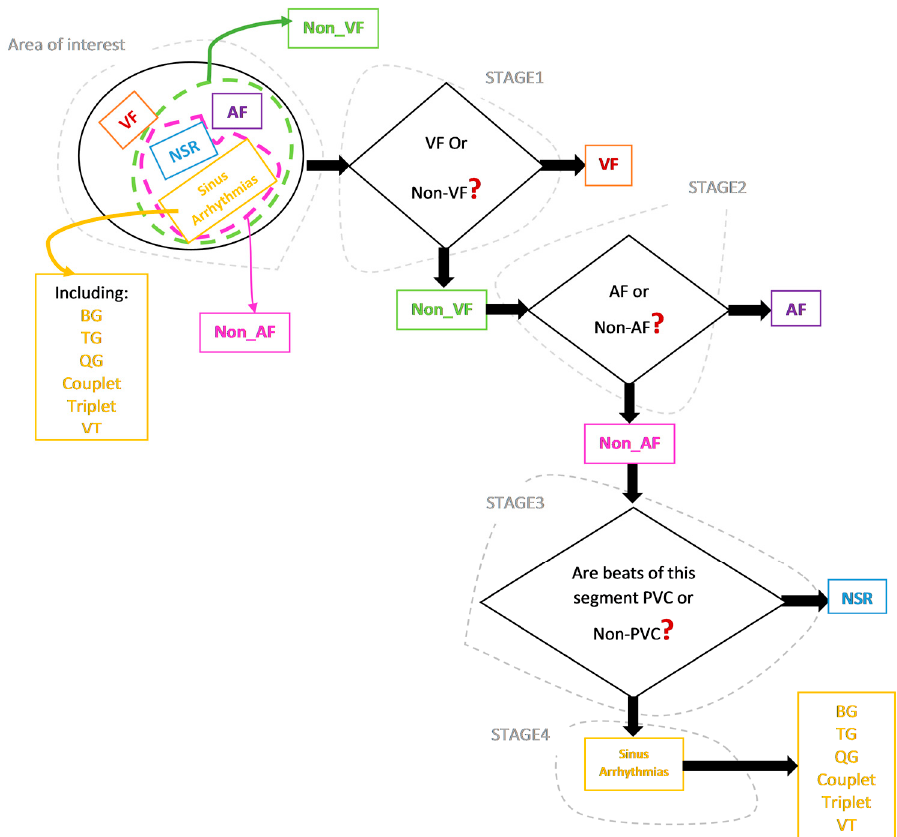
Figure 1. The proposed approach to detect multiple types of malignant arrhythmic episodes. AF: atrial fibrillation; VF: ventricular fibrillation; PVC: premature ventricular contraction; NSR: normal sinus rhythm; BG: bigeminy; TG: trigeminy; QG: quadrigeminy; VT: ventricular tachycardia.